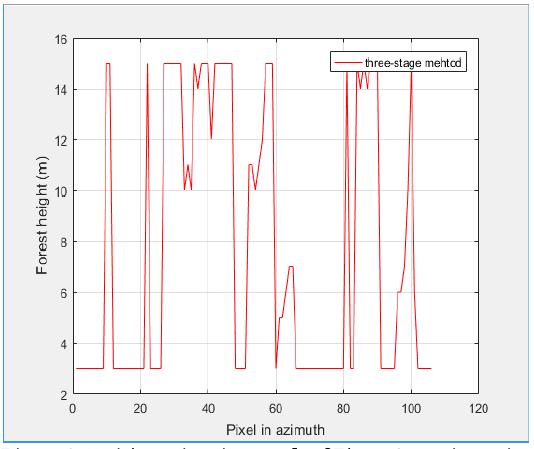
Figure 6. Height estimation result of Three-Stage inversion